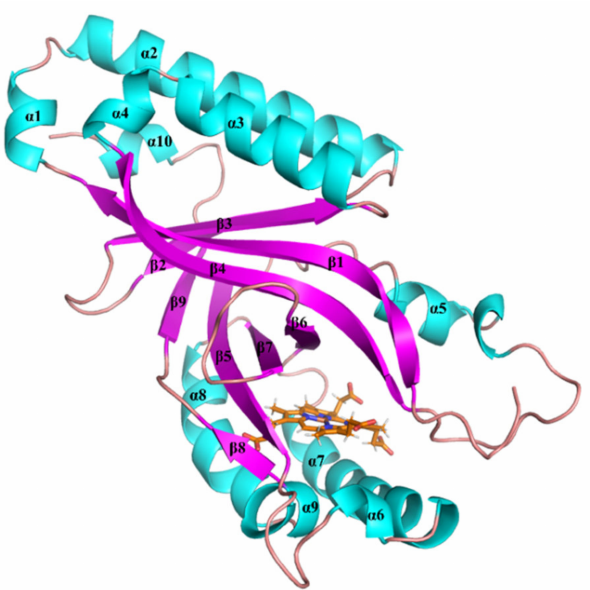
Figure 4. Representative structure for FM3 from the MD ensemble. The different secondary structures of the monomer model are marked as cyan for α -helix and magenta for β